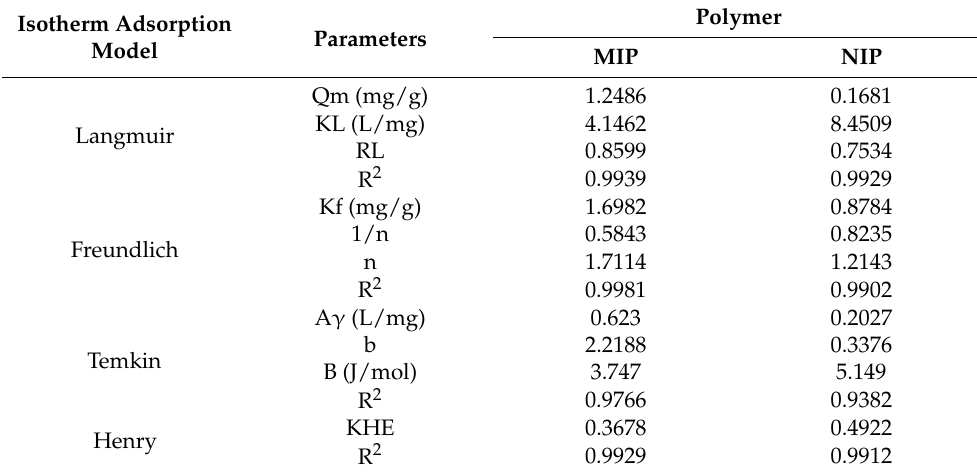
Table 2. Isotherm Adsorption parameters of MIP and